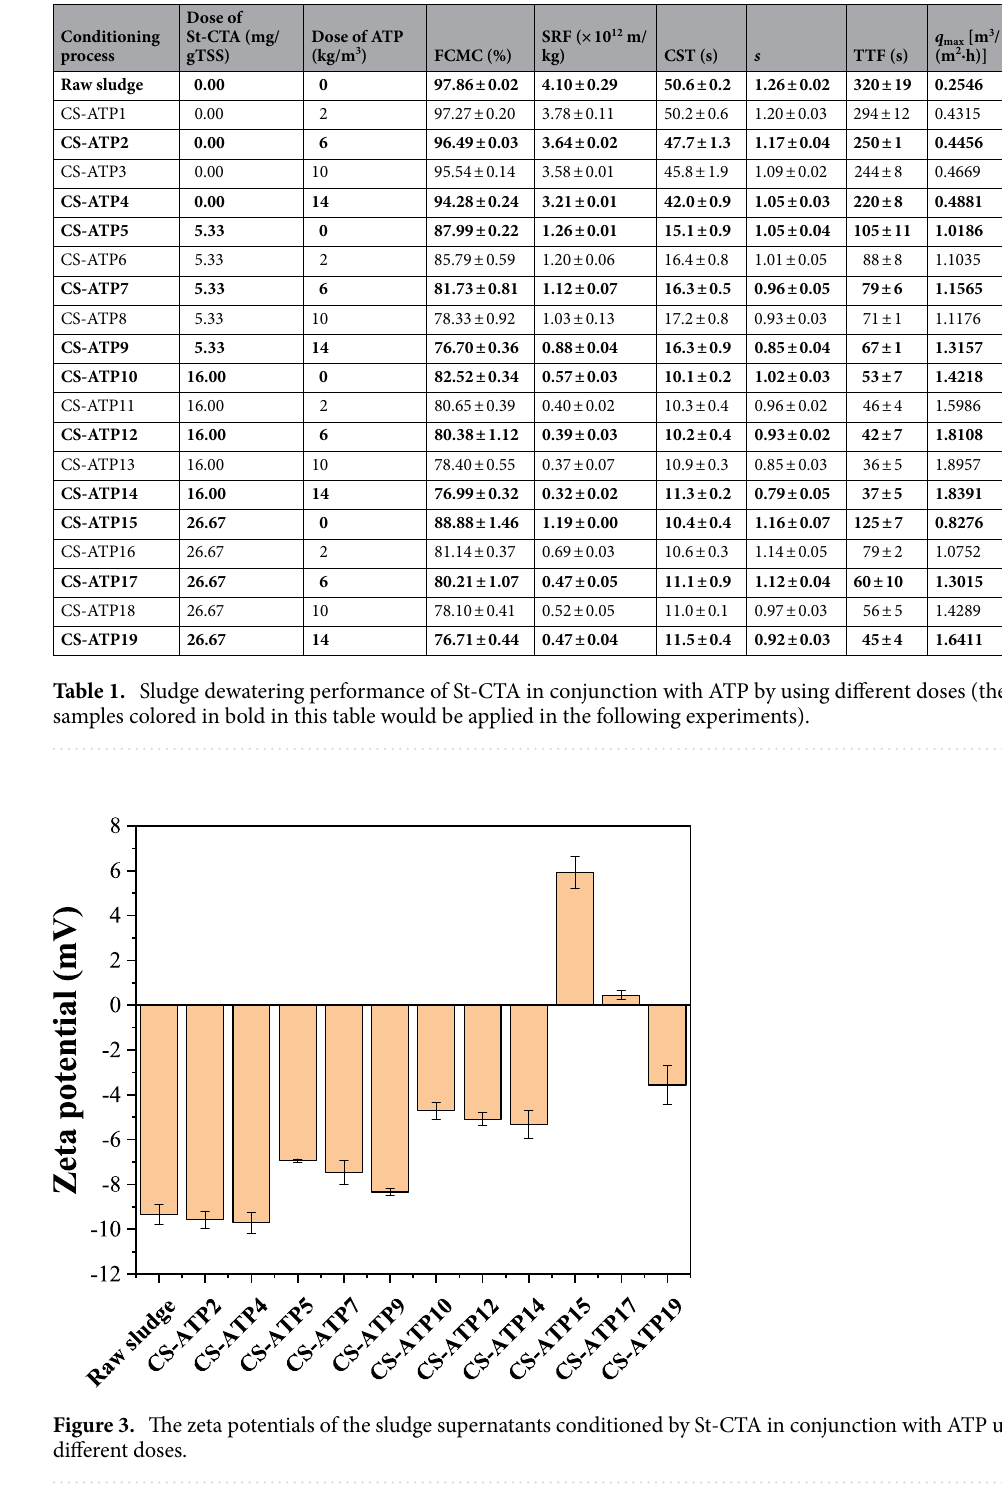
ATP dose of 14.00 kg/m 3 (CS-ATP14, Fig. 1, Table 1). When the ATP dose increased further, the improvement in dewatering performance was quite limited (Supporting Information Fig. S6) but the resultant sludge mass was accordingly constantly increased. In addition, ATP dosed after St-CTA could also obviously alleviate the restabi- lization effect 6,23,24 . When St-CTA was overdosed at the dose of 26.67 mg/gTSS, the FCMC improved from 88.88 to 76.71% at the ATP dose of 14.00 kg/m 3 (CS-ATP19, Fig. 1 and Table 1). The negatively surface charged solid particulates of ATP could act as a skeleton builder to reduce the compressibility of sludge and further improve the FCMC (Figs. 1a, 2), besides, could neutralize and combine the excessive positive charges of overdosed St-